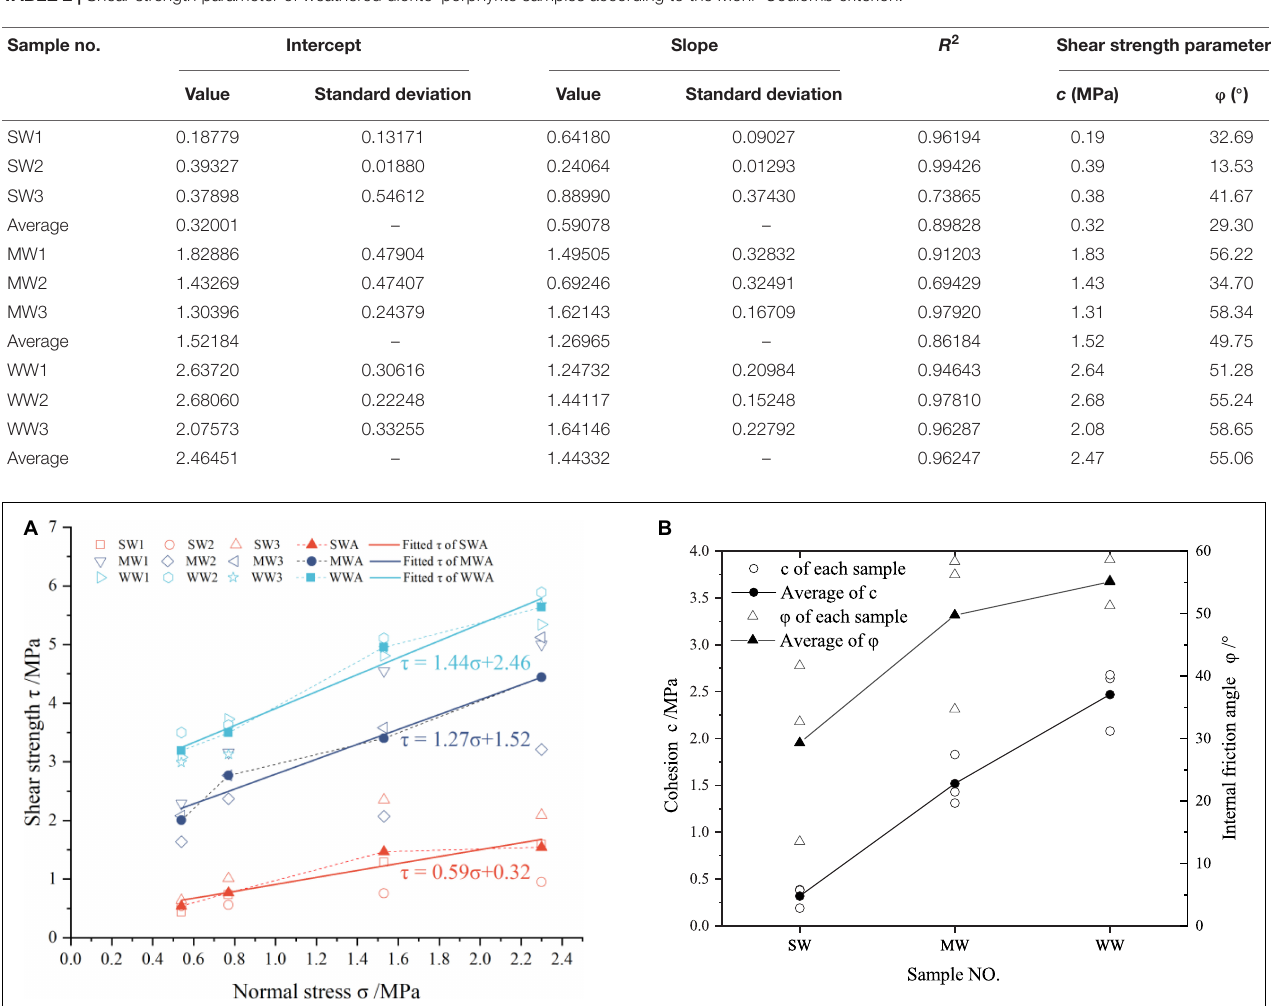
FIGURE 6 | Shear strength parameters of samples according to the Mohr–Coulomb criterion. (A) Direct shear test results and Mohr–Coulomb fits. (B) Cohesion and internal friction angle of the samples.